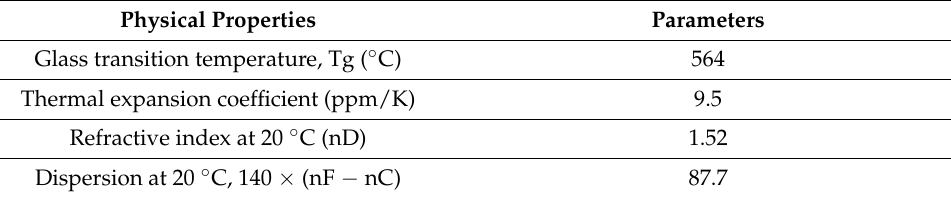
Figure 3 . The ultrasonic polishing path followed by CNC machine. Table 1. The physical properties of soda lime